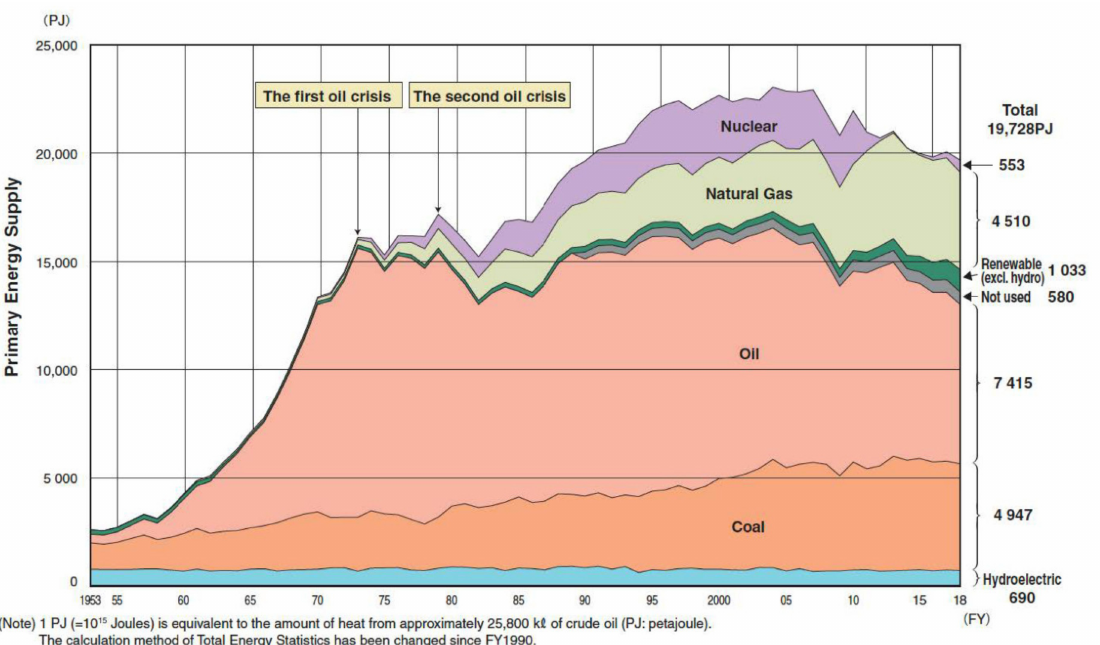
Figure 2. Historical trends in Japan’s primary energy supply. Source: Agency for Natural Resources and Energy, Total Energy Statistics. Japan Atomic Energy Relations Organization (JAERO)